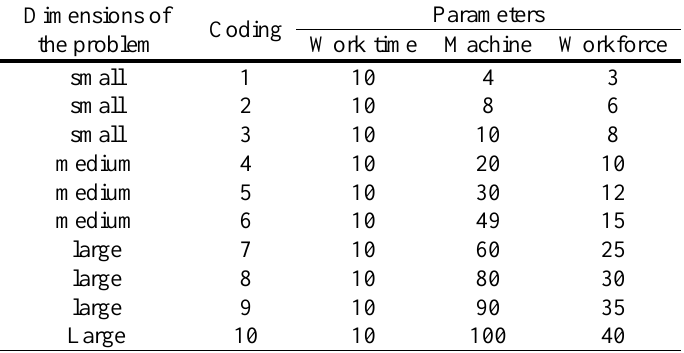
Table 2. Levels of DOE factors and issues dimensions.